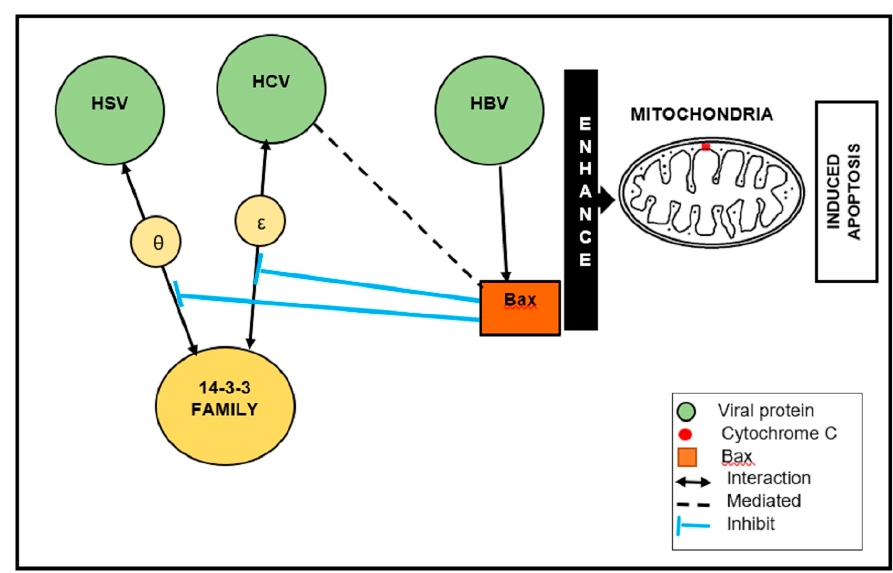
Figure 2. Schematic illustration of the Bax-mediated apoptosis of herpes simplex virus (HBV), hepatitis C virus (HCV), and hepatitis B virus (HBV). HBV, HCV, and HSV directly associate with, or inhibit, cellular protein 14-3-3 to induce apoptosis.